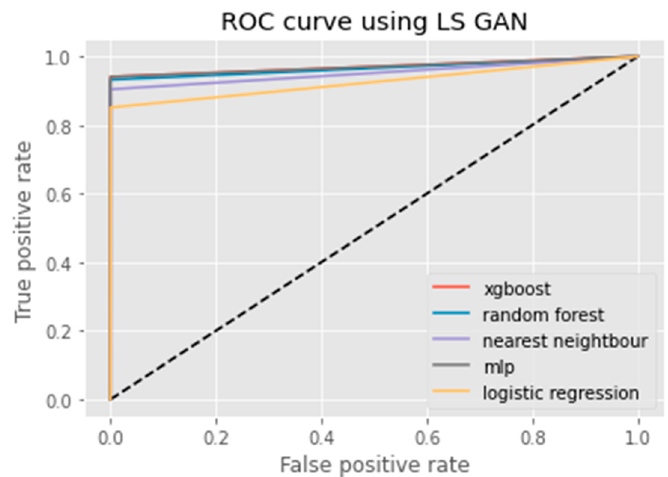
Figure 10. ROC curve using NS GAN.